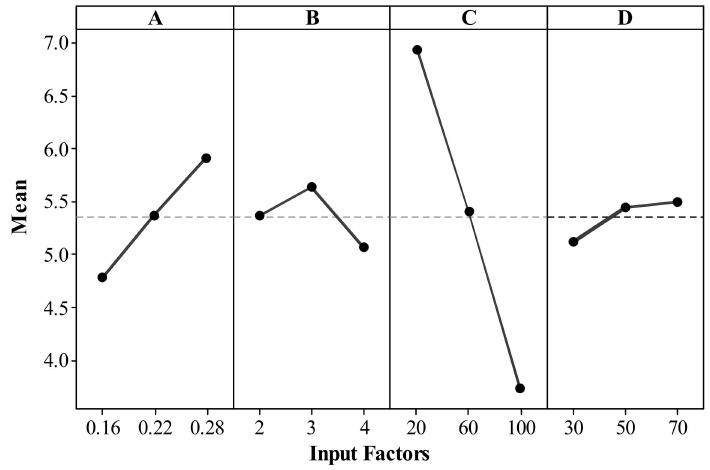
Figure 5. Main effect plots for